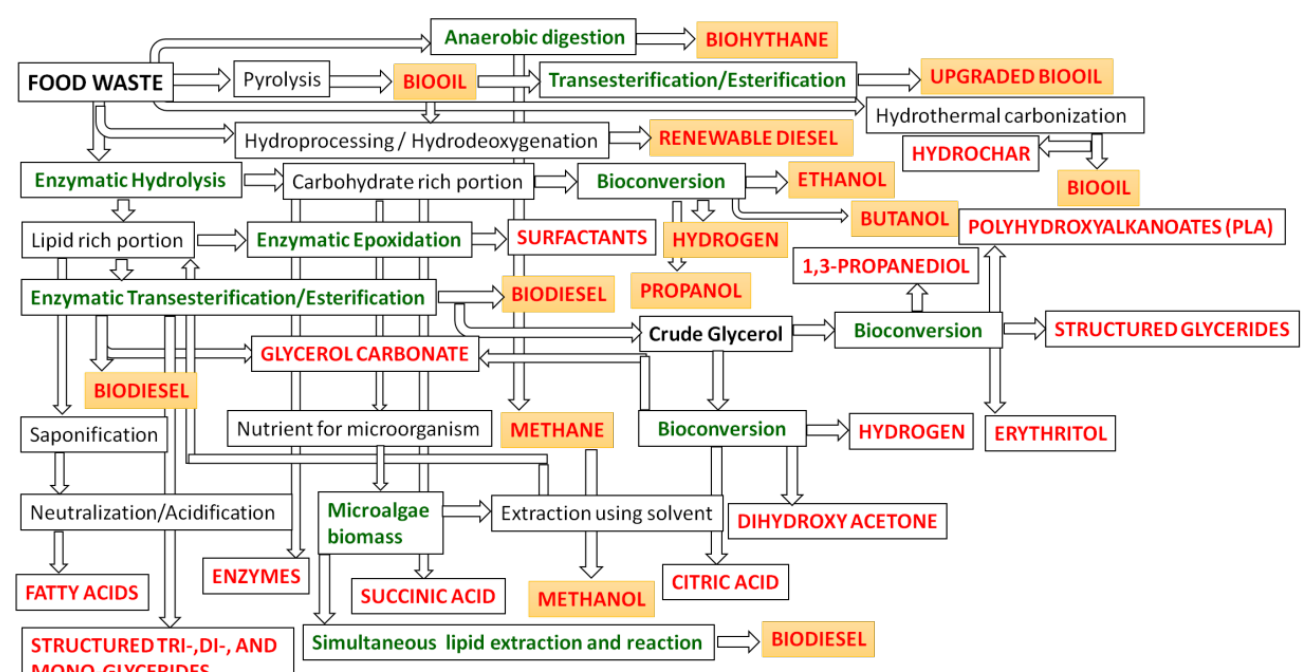
Figure 7. A proposed food waste-based biorefinery using biocatalysis (green color show the methods can be performed using enzymes; gaseous biofuels: hydrogen, methane and biohythane; liquid biofuels: biodiesel, methanol, ethanol, propanol, butanol, biooil, upgraded biooil, and renewable diesel).